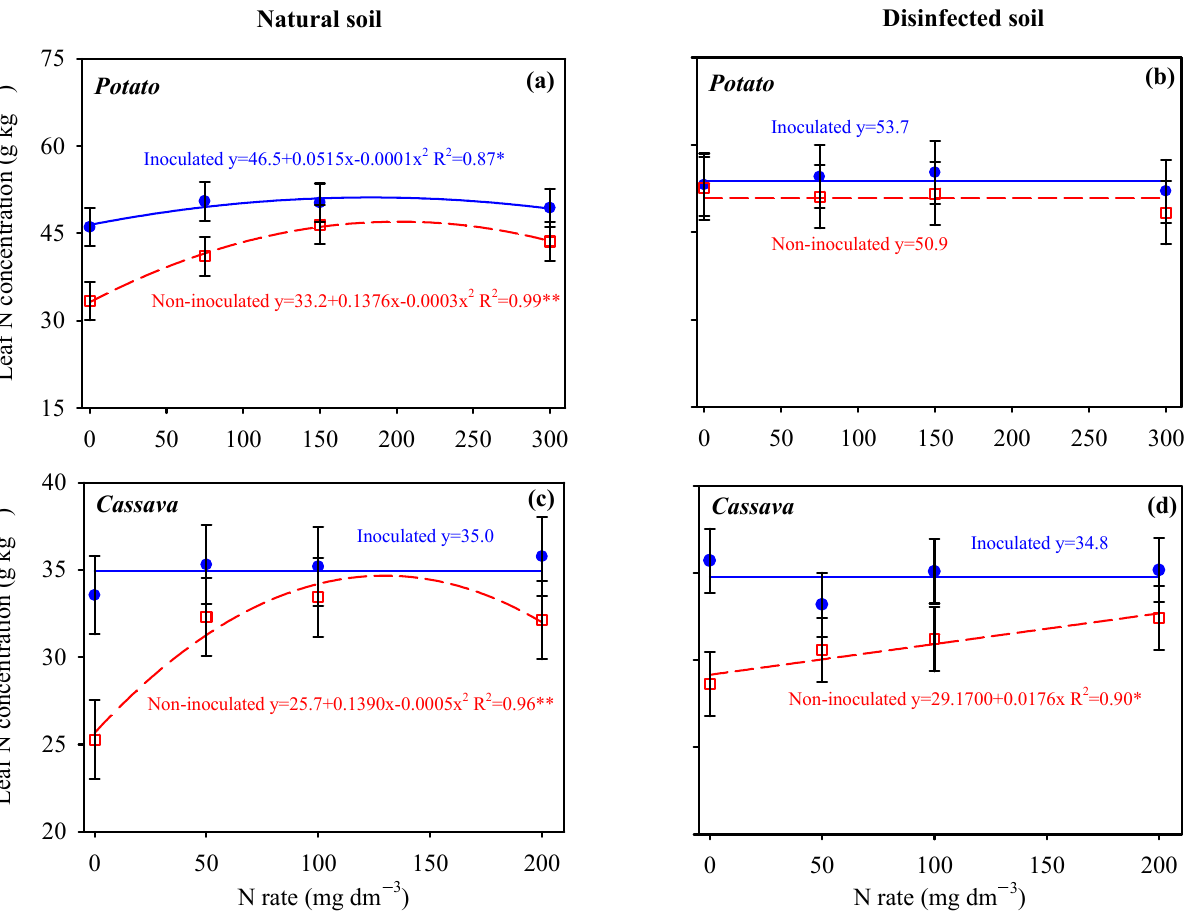
Figure 1. Leaf nitrogen (N) concentration of potato ( a , b ) and cassava ( c , d ) in response to N application rates and A. brasilense inoculation in natural and disinfected soil. Bars represent the least significant difference between A. brasilense inoculation in the same N rate at p < 0.05 according to the LSD test. * p < 0.05; ** p < 0.01.